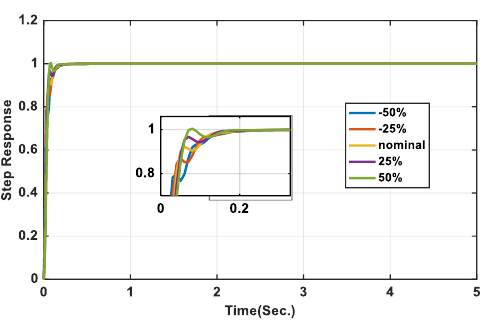
Figure 12. Comparison of unit step response of AVR system by considering uncertainty in exciter.